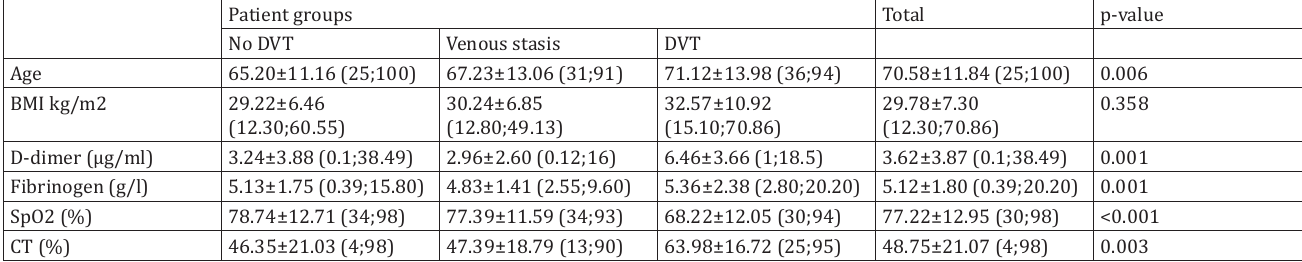
Association of quantitative variables with DVT (mean ± standard deviation (min; max))